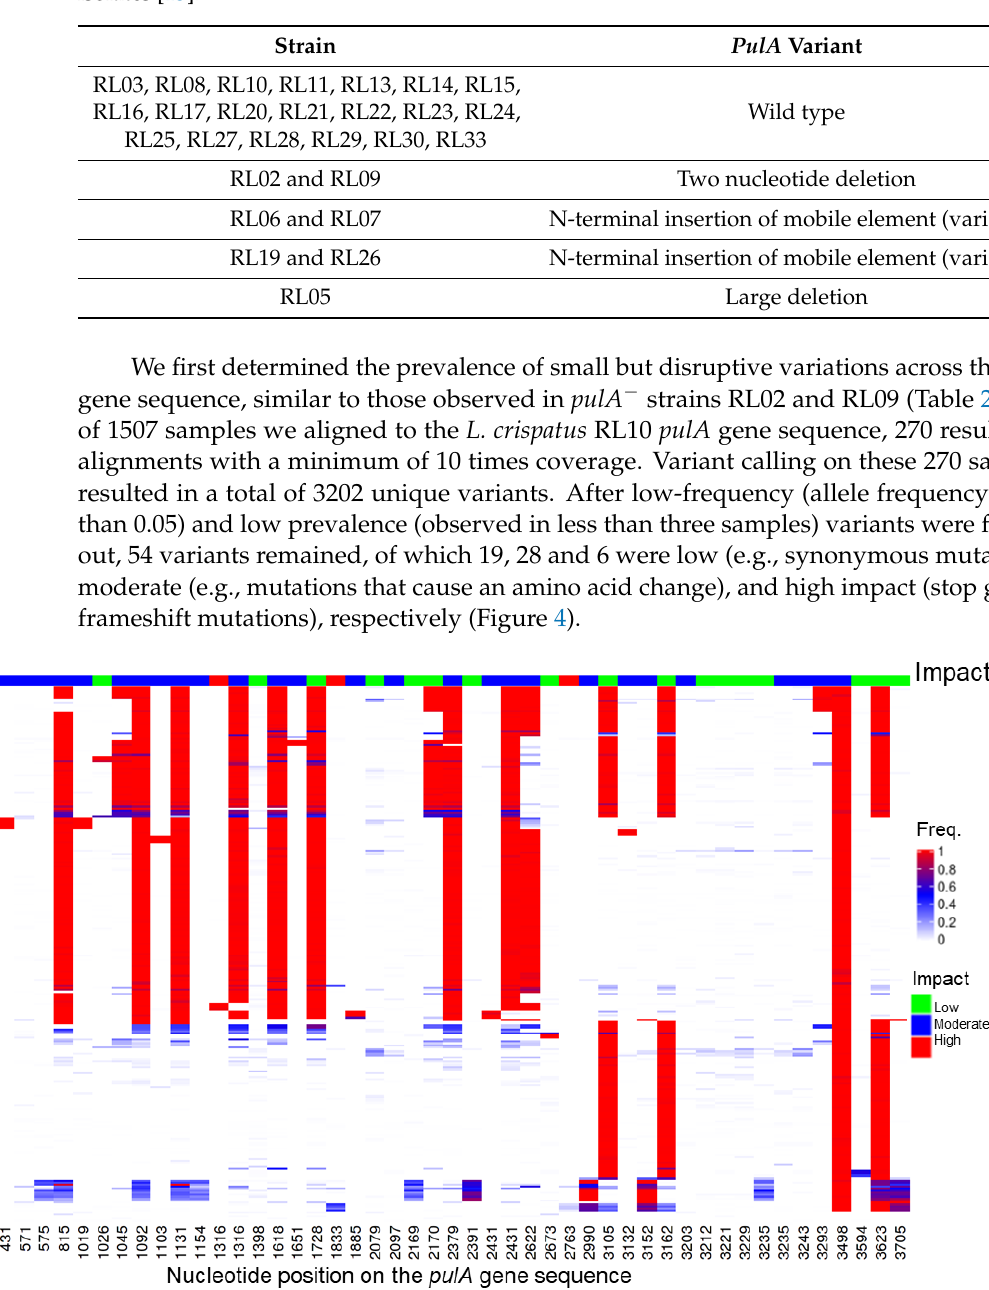
Table 2. Overview of amylopullulanase variants in our strain collection of human vaginal L. crispatus isolates [13].